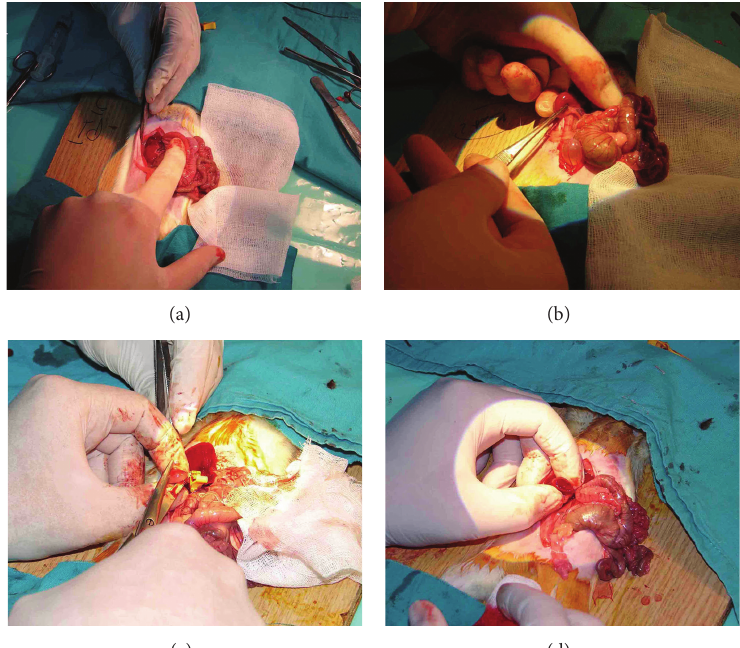
Figure 4: (a) and (b) Traditional partial nephrectomy model with suture on resected area dissection of kidney. (c) and (d) Transection of kidney and application of